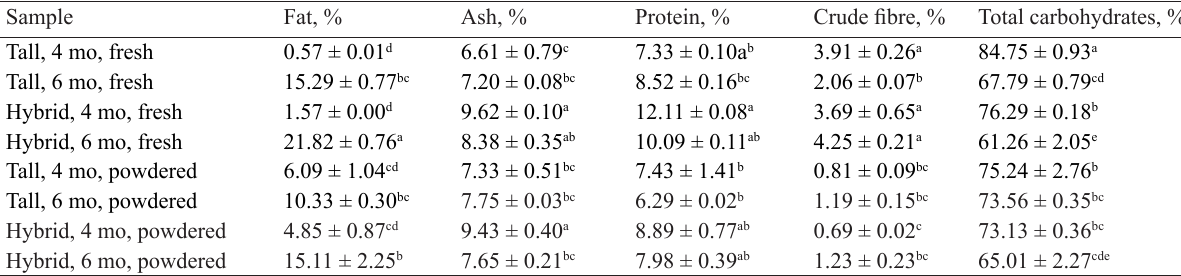
Table 1 The proximate analysis offresh and powdered coconut drinks (mean ± SD) Sample Fat, % Ash, % Protein, % Crude fibre,